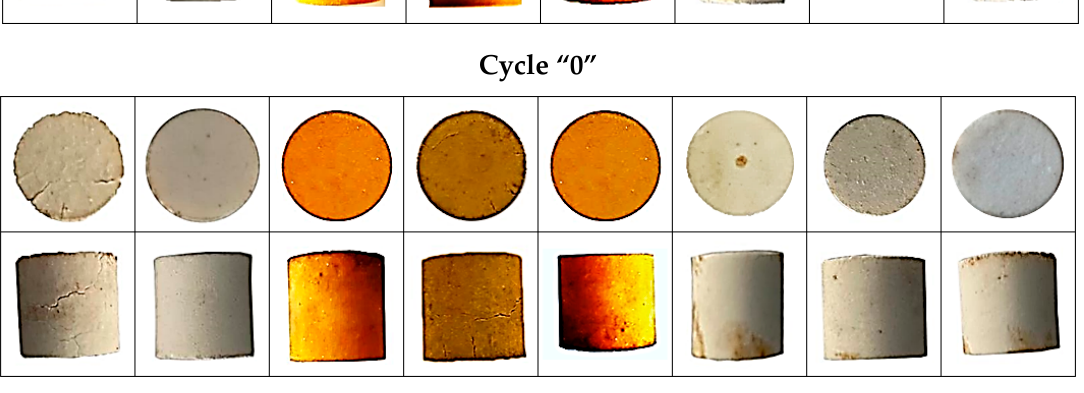
Figure 7. Comparison of morphological integrity of PSAN cylinders after being subjected to four thermal cycles.